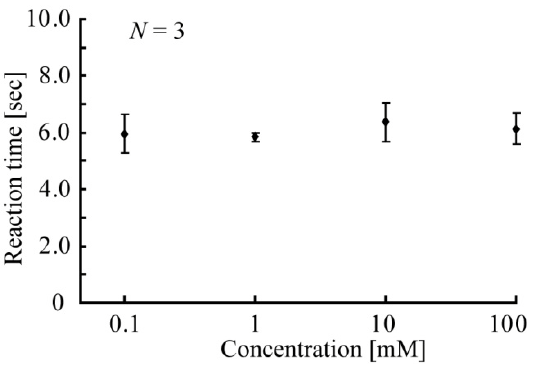
Figure 7. Relationship between glucose concentration and reaction